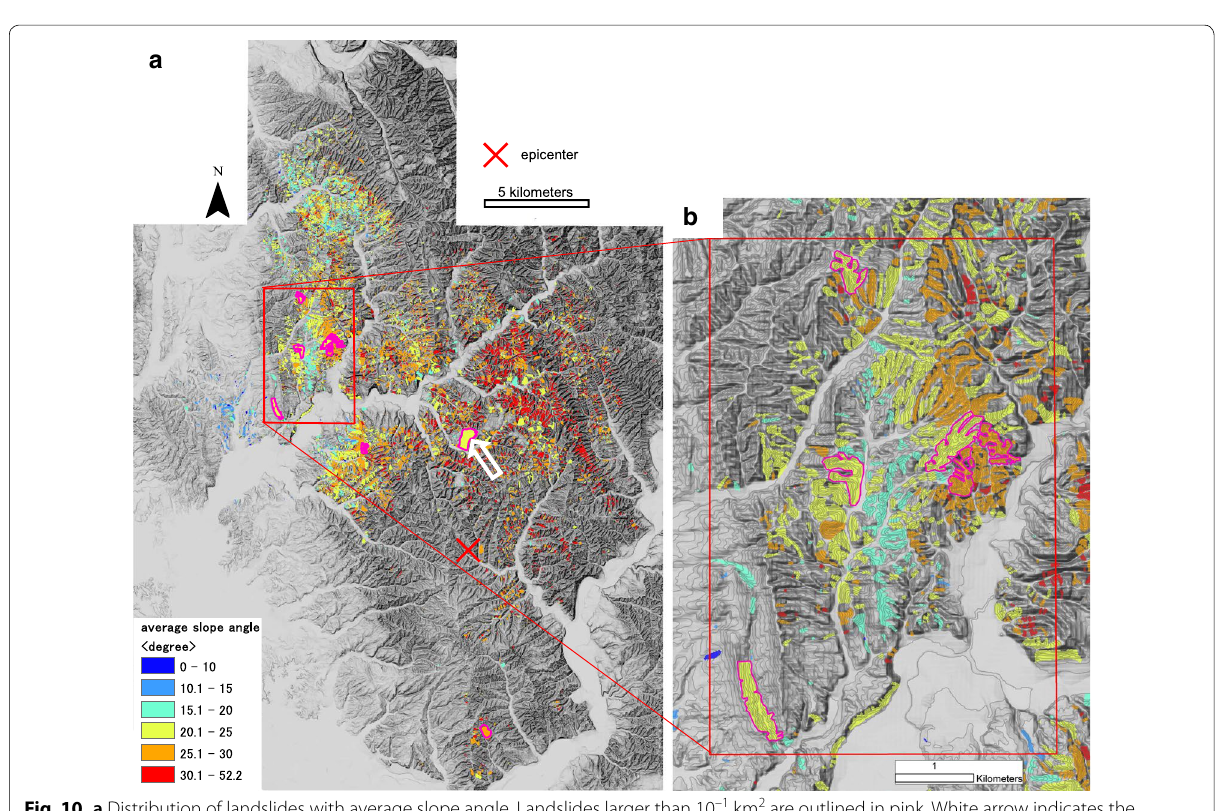
Fig. 10 a Distribution of landslides with average slope angle. Landslides larger than 10 –1 km 2 are outlined in pink. White arrow indicates the